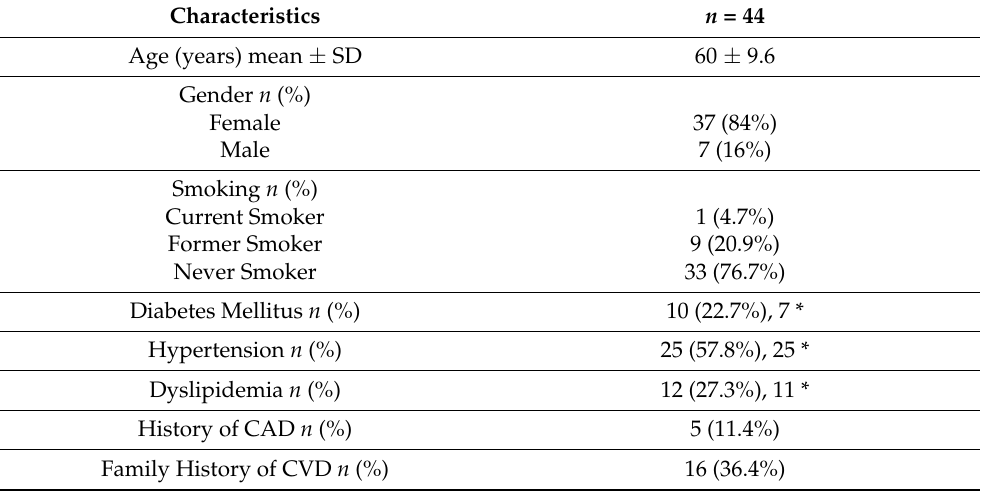
Table 1. Baseline